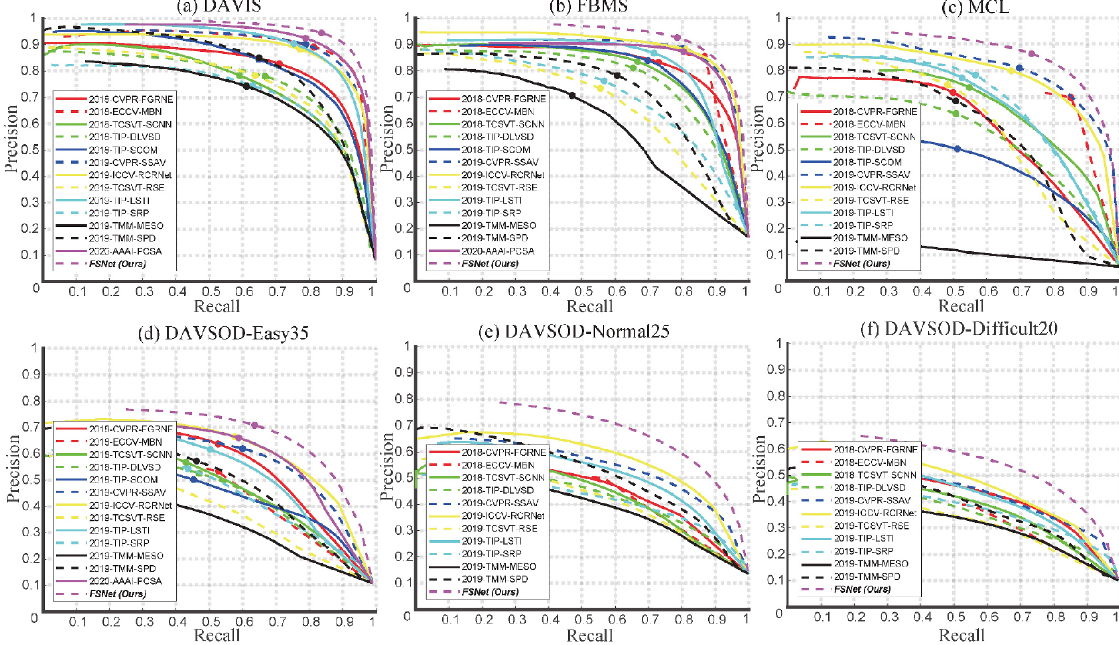
Fig. 6 Precision–recall curves of SOTA V-SOD methods and our proposed FSNet across six